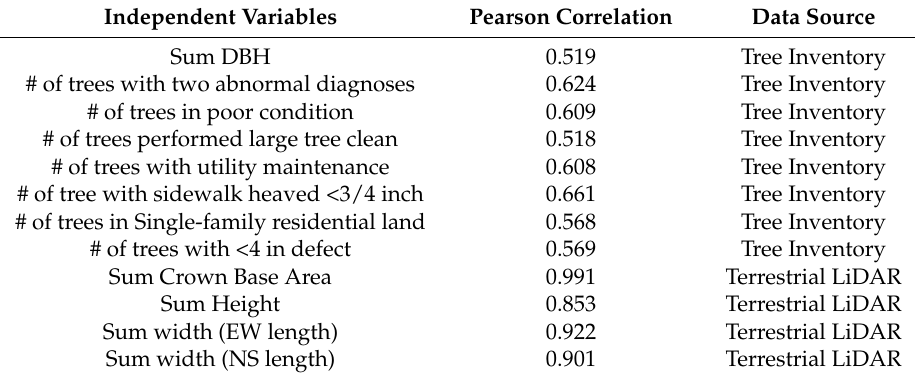
Table 2. Correlation between frontal area from TLiDAR and the independent variables.